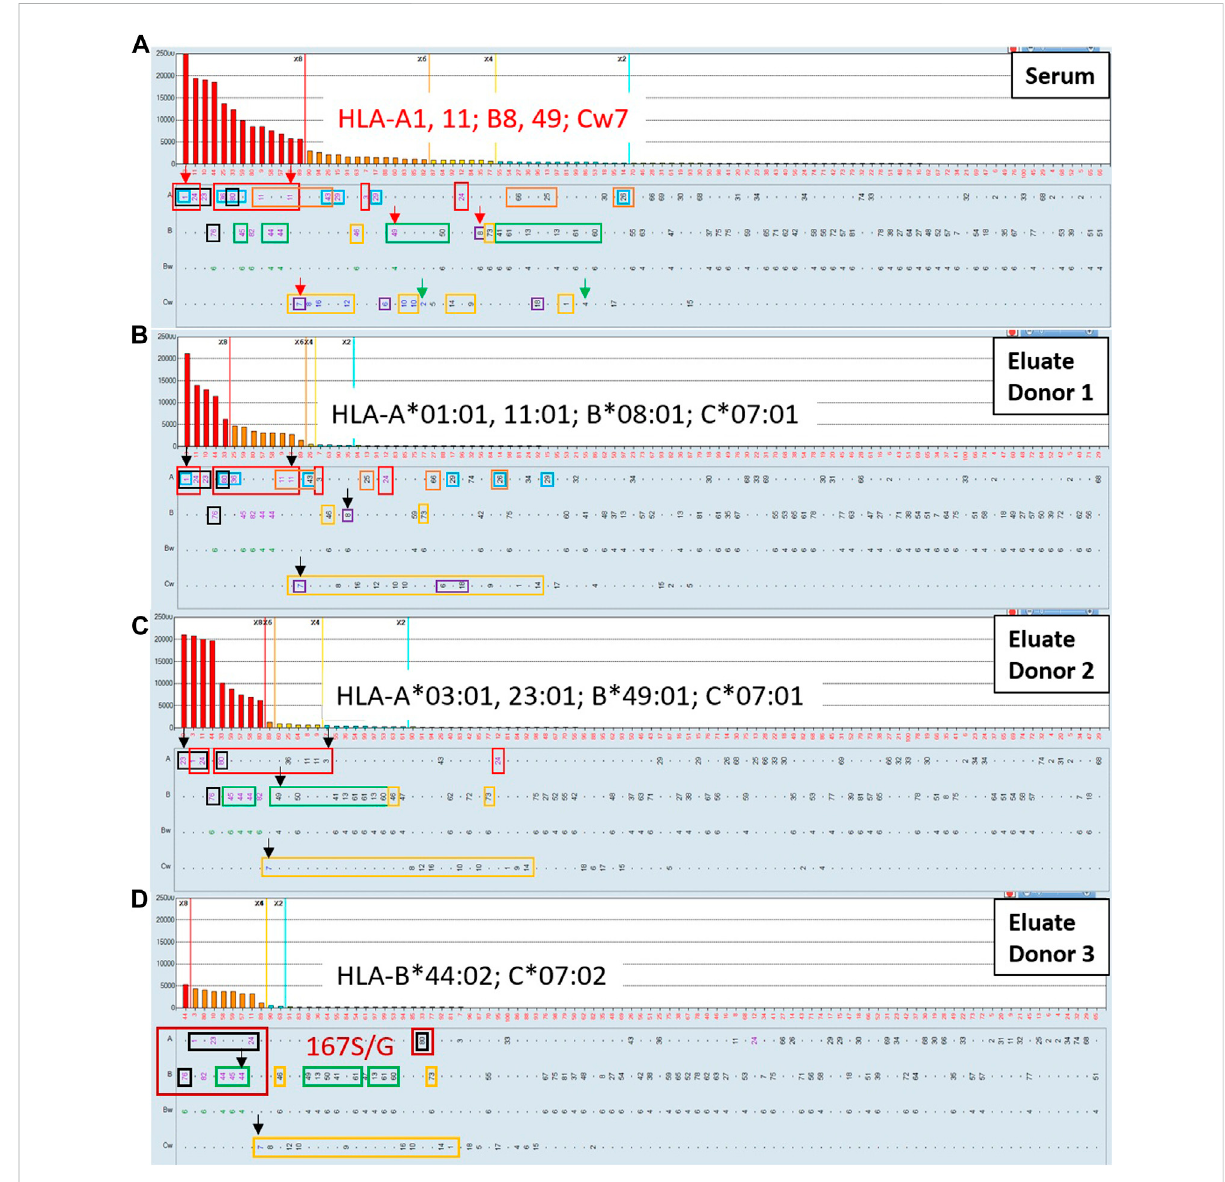
FIGURE 8 TheAXEprotocolallowsforaccuratecharacterizationofpost-transplantclassIHLAantibodypatternsincludingweakantibodyreactivities.SAB images of Class I HLA speci fi cities ina post-transplant sensitized patient ’ sserum (A) and the AXE eluate using cells from surrogatedonor 1 (B) , donor 2 (C) and donor 3 (D) are shown. Mean fl uorescence intensity (MFI) values are displayed on the Y axis. The SAB HLA speci fi cities ( X axis) are sorted in order of decreasing MFI. Previous transplant donor mismatched antigens are listed in red font and indicated with red arrows (A) . Patient ’ s self HLAantigensareindicatedwithgreenarrows (A) .Mismatcheddonorspeci fi calleles fortheAXEdonor1,donor2anddonor3arelistedineachpanel in black font and indicated with black arrows (B – D) . HLA antigens expressing the relevant mismatched donor eplets: (76ANT blue, 144TKR red, 163RW orange, 166DG black, 9D purple, 41T green, and 76VRN yellow rectangles) are indicated. The speci fi cities expressing novel 167S/G epitope are highlighted with dark red rectangles (D)